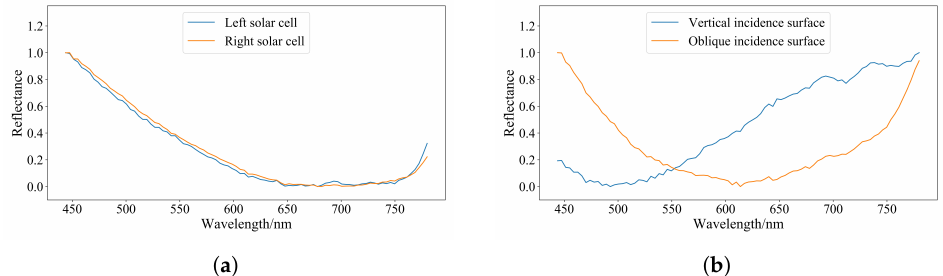
Figure 24. Spectral data distributions of low spatial resolution and positive Y-axis incidence: ( a ) left and right solar cells; ( b ) gold mylar on different